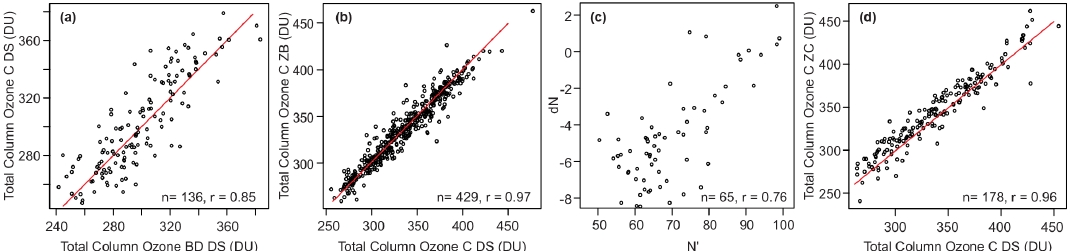
Figure 4. Comparisons of (a) BD and C wavelength pair direct-sun calculations, (b) fitted C ZB data against C DS observations, (c) d N versus N (cid:48) for C ZC observations and (d) reduced C ZC observations versus quasi-simultaneous C DS observations. Here results are shown for the case with Bass–Paur absorption coefficients; plots for the adjusted coefficients are indistinguishable. One-to-one lines are shown in red.